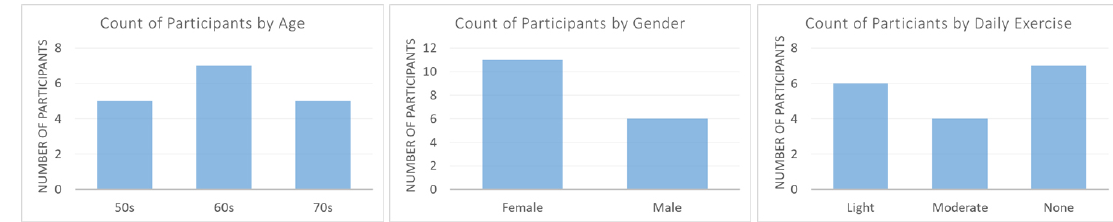
Figure 7. Distribution of participants based on their age, gender and daily